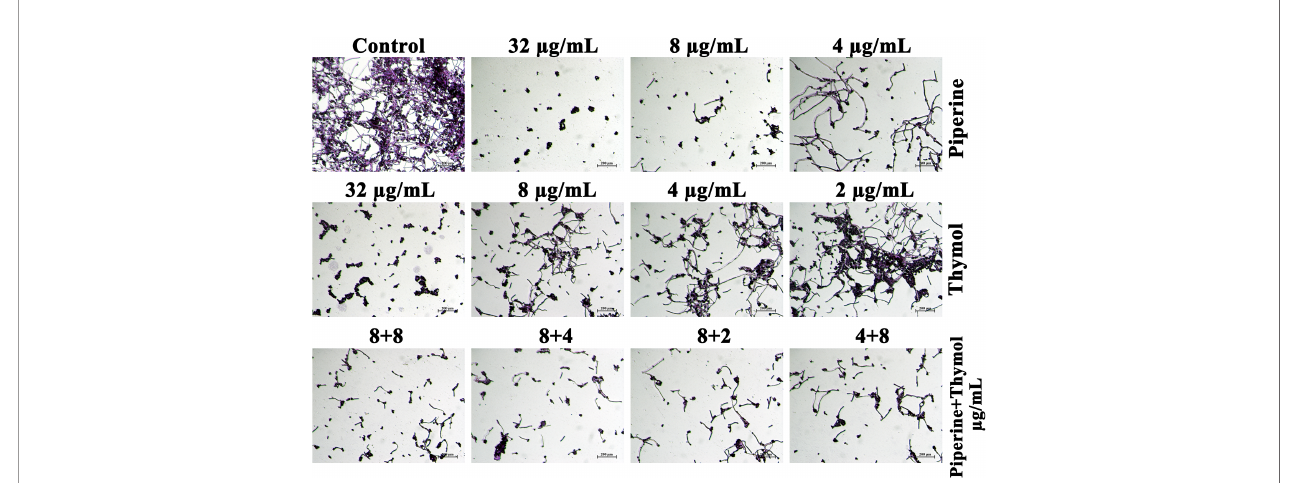
FIGURE 5 | Microscopic visualisation of C. albicans bio fi lm formed under the in fl uence of the synergistic effect of piperine and thymol. Bio fi lm of C. albicans without any treatment is encased with the conglomeration of yeast cells and fi laments. Scarcely distributed yeast cells alone were found in the piperine and thymol-treated C. albicans. Few hyphal elongations were observed in treatment with sub-BIC of the phytochemicals. Synergistic combinations of piperine and thymol reduced the adherence of cells and fi lamentous morphology.